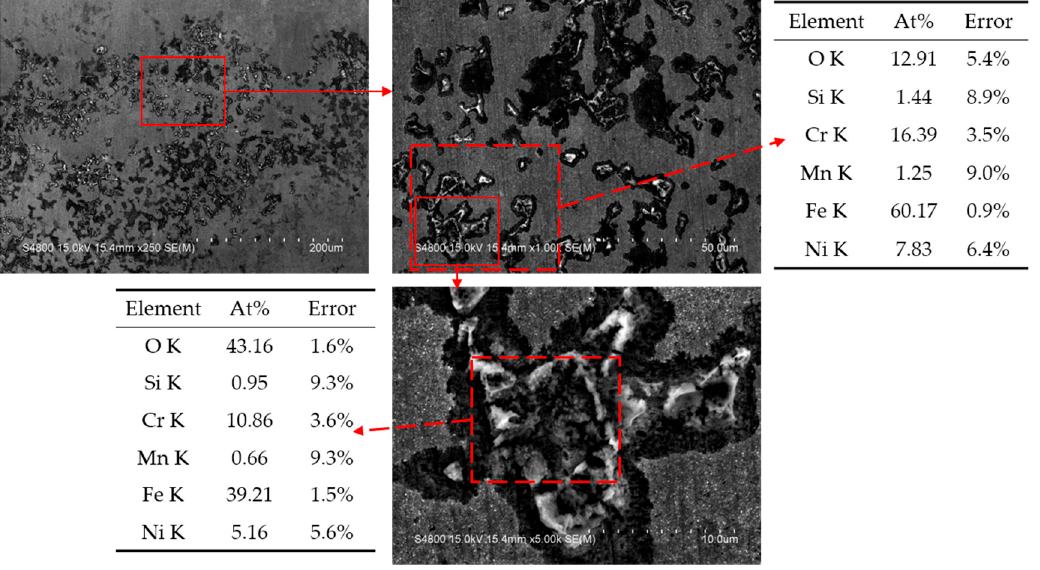
Figure 8. SEM images and the corresponding composition analysis of the passive film formed on 304L with the blank treatment.